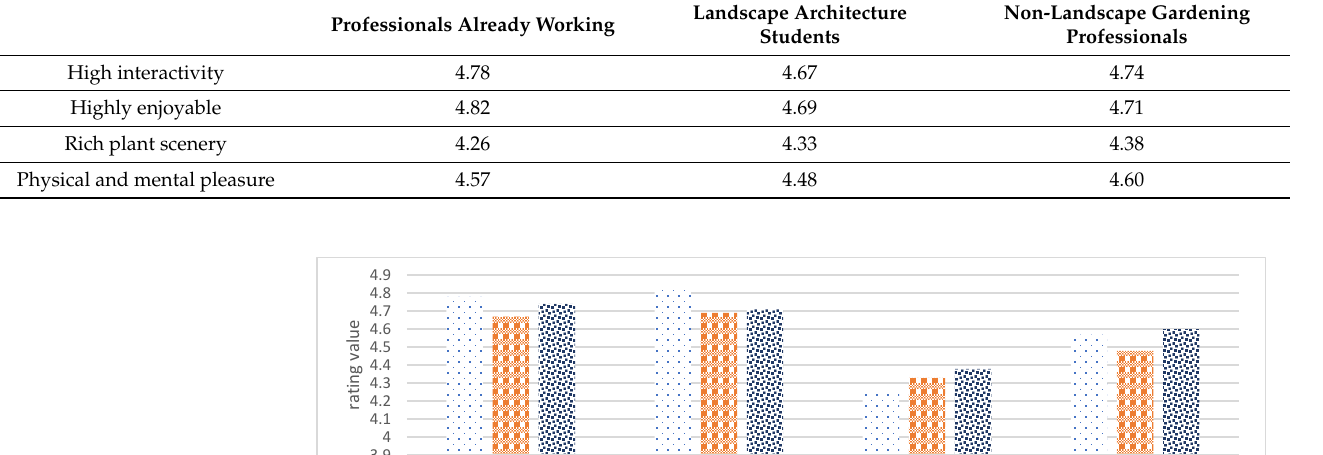
Table 3. Respondents’ evaluation of the effectiveness of computer vision-based MID.